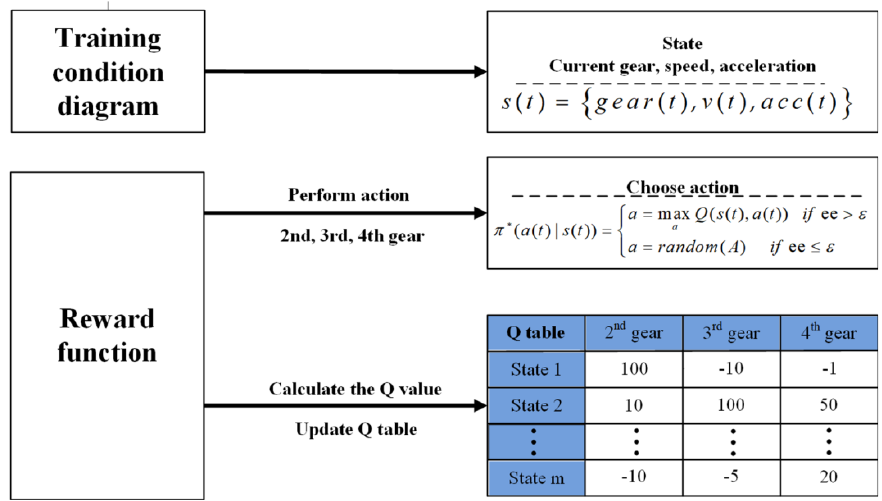
Figure 7. Q table offline training.